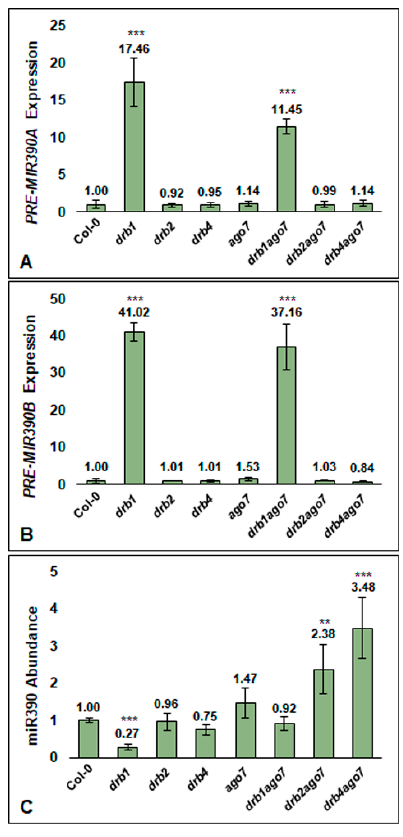
Figure 3. RT-qPCR quantification of miR390 precursor transcript expression and miR390 sRNA abundance. ( A–C ) RT-qPCR assessment of the expression of miR390 precursor transcripts, ( A ) PRE- MIR390A and ( B ) PRE-MIR390B , and ( C ) the abundance of the miR390 sRNA for the terminal floral buds of 42-day old Col-0, drb1 , drb2 , drb4 , ago7 , drb1ago7 , drb2ago7 and drb4ago7 plants. Error bars represent the standard error of the mean of the four biological replicates assessed. The fold change in expression relative to Col-0 plants is presented above each column. The presence of an asterisk above a column represents a statistically significant difference between the mutant plant line and Col-0